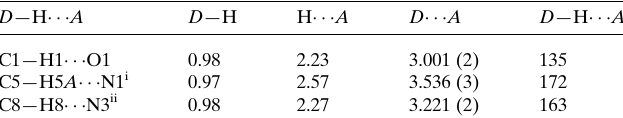
Table 1 Hydrogen-bond geometry (A˚ , (cid:2) ).